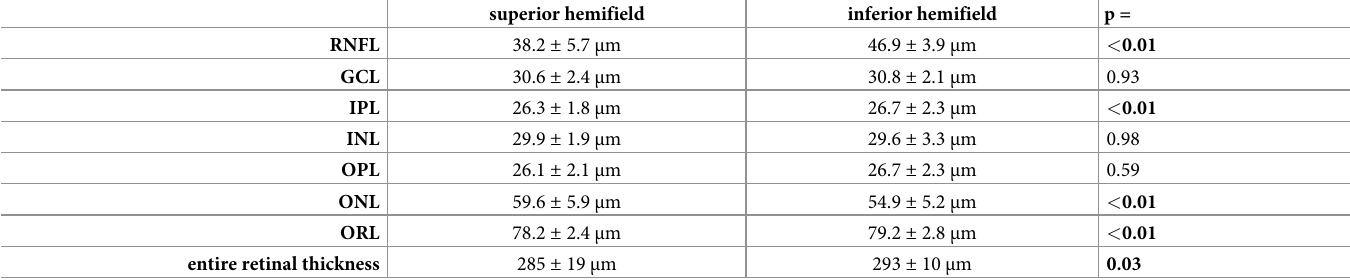
Table 2. Hemifield analysis in the control group. Mean thickness of retinal layers and the entire retina in the macular region in the superior and inferior hemifield above and below the dividing line connecting the foveola and the central optic nerve head. Significant differences between the superior and inferior hemifields were found for the RNFL, IPL, ONL, ORL as well as for the complete retinal